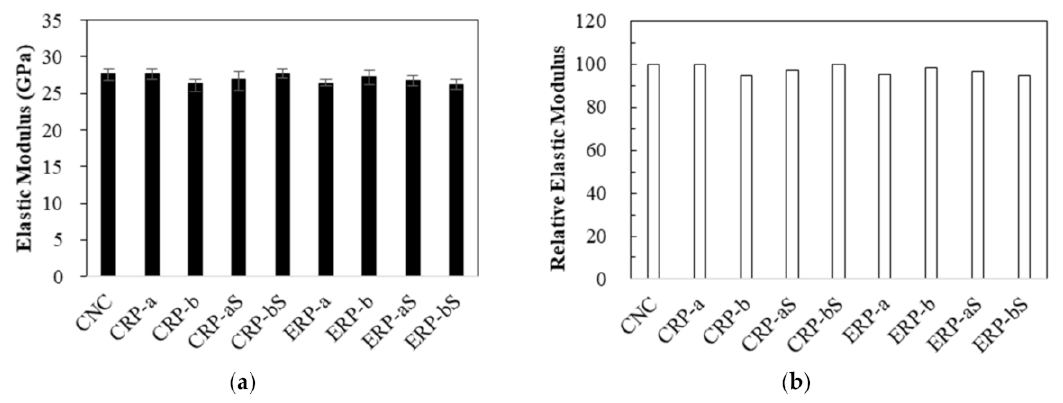
Figure 7. Elastic modulus and relative values: ( a ) elastic modulus and ( b ) relative elastic